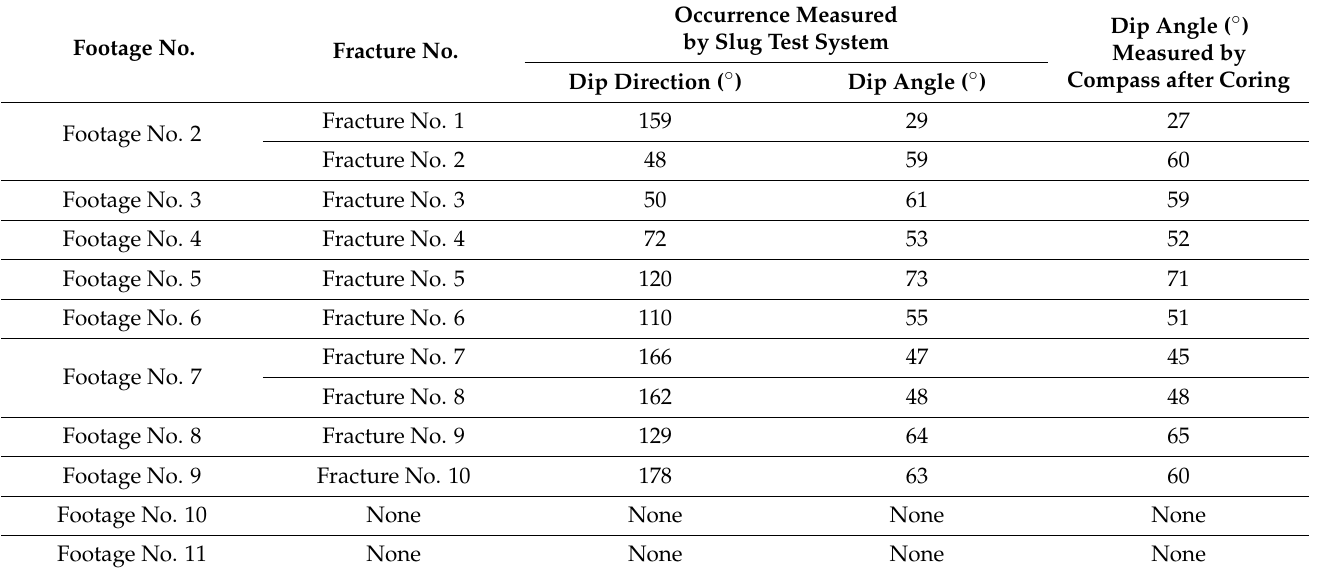
Table 2. The contrast of geological information obtained by the slug test system and manual mea- surement after